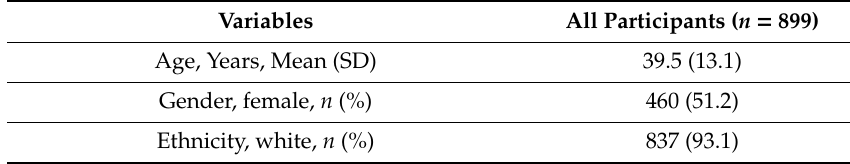
Figure 2. Flow chart. Table 1. Participants characteristics.